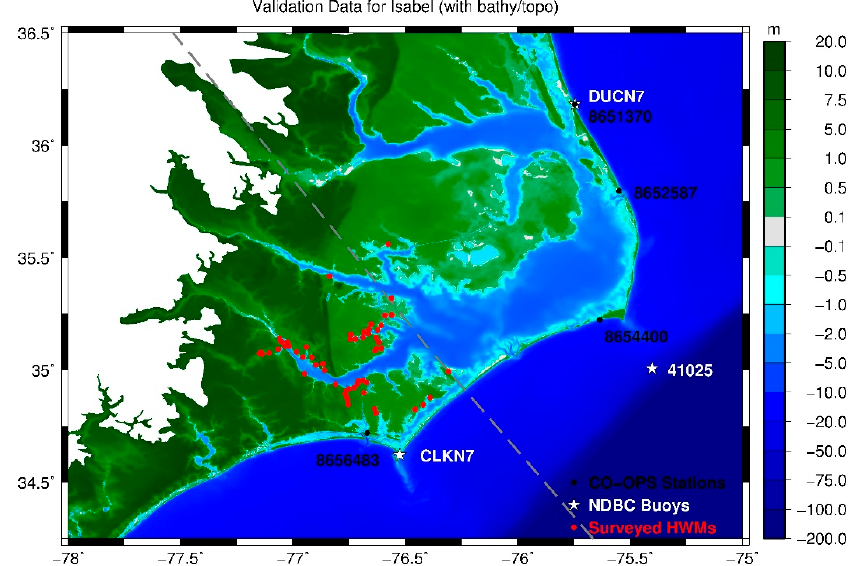
Figure 4. Location of available data used during validation of Hurricane Isabel: Dashed gray line denotes the storm track, black points denote CO-OPS stations, white stars denote NDBC buoys, and red points denote the subset of sixty HWMs which were used herein. Only the nearshore buoys are shown here, the offshore locations were given above in Figure 2b.